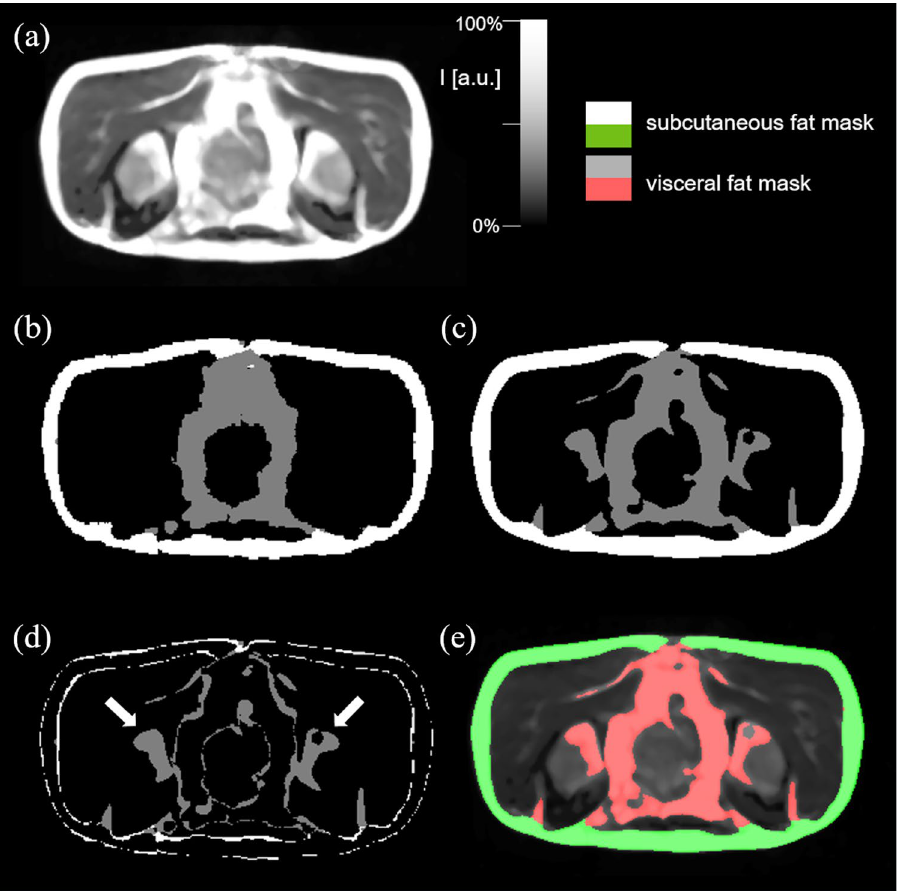
Figure 1. Prediction results from a test dataset from a control. ( a ) Original transversal MRI single plane image. ( b ) Reference segmentation mask. ( c ) Predicted label map. ( d ) Difference image between reference and predicted segmentation with arrows indicating major differences in prediction of VAT in hip bones. ( e ) Predicted segmented mask overlaid on original MR